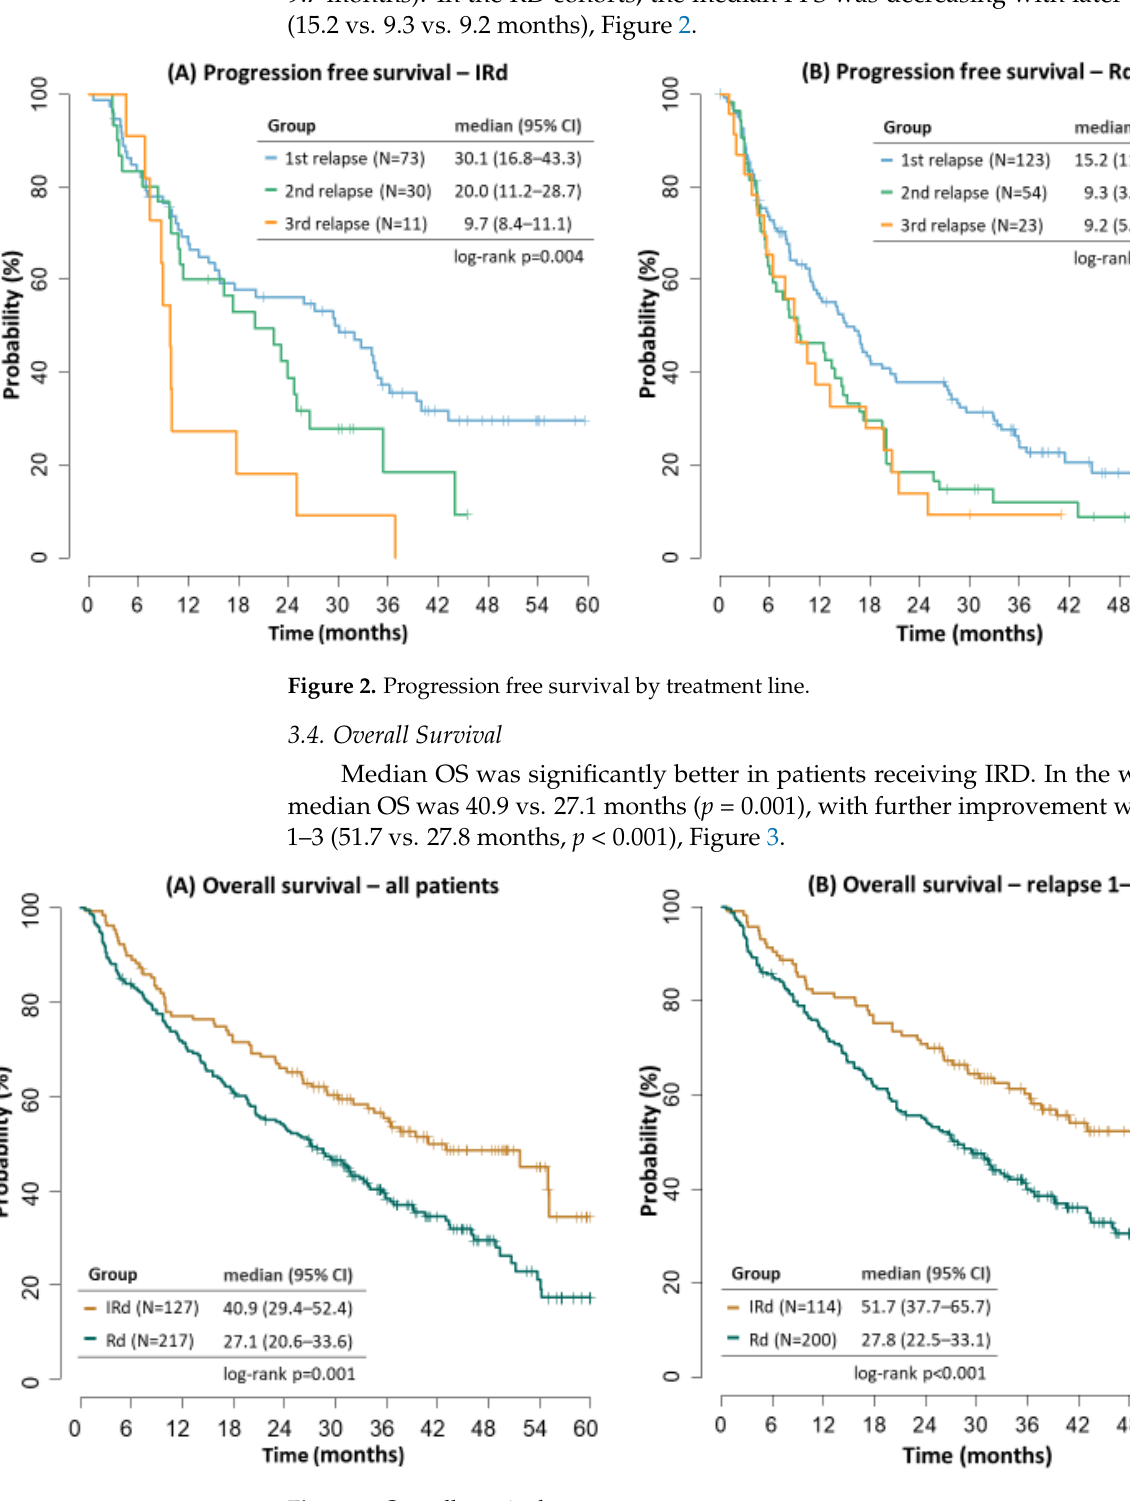
Figure 1. Progression free survival.